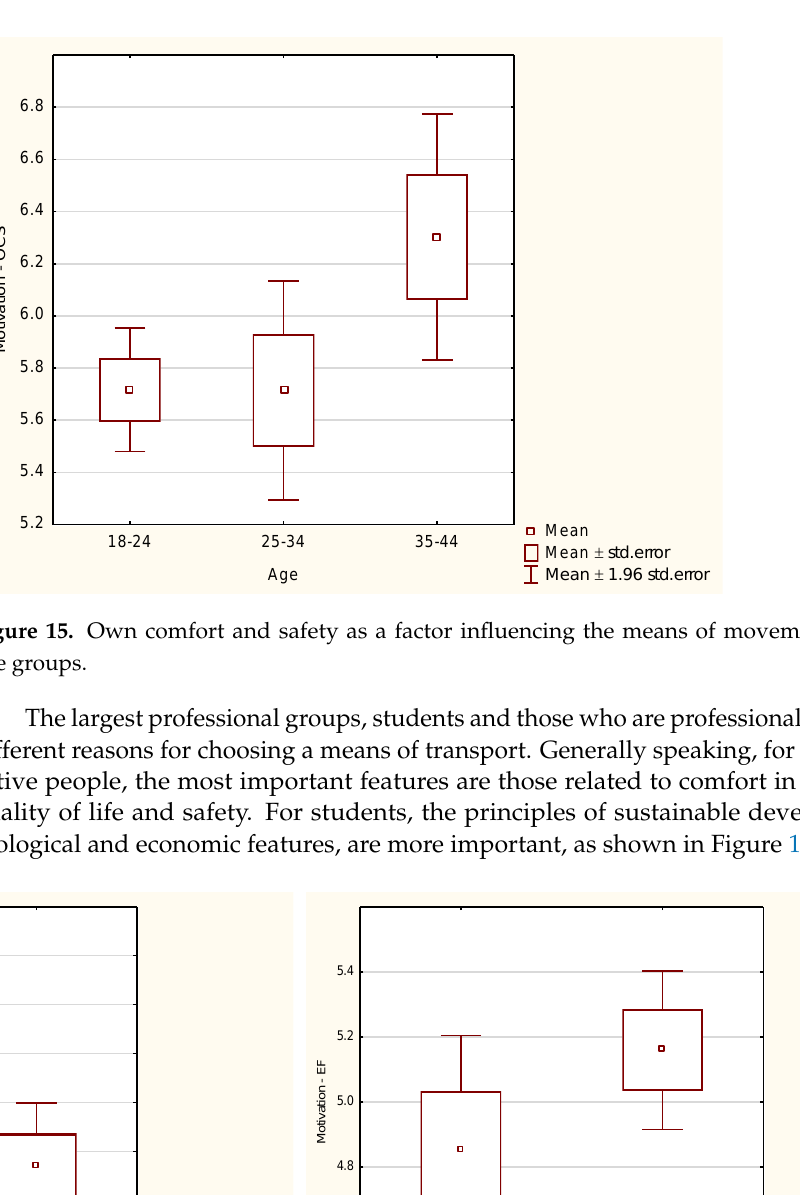
Figure 17. SDP and QL as factors influencing mobility choice at different education levels. When looking at different areas of residence, the greatest differences were visible in terms of the principles of ecology (1 — Szczecin, 2 — Vicinity, 3 — West Pomeranian Voi- vodeship, 4 — other). Respondents living in Szczecin and the West Pomeranian Voivodeship are less influ- enced by ecological factors when choosing a method of transport. However, inhabitants of the vicinity of Szczecin demonstrated the highest level of ecological awareness (Figure 18).